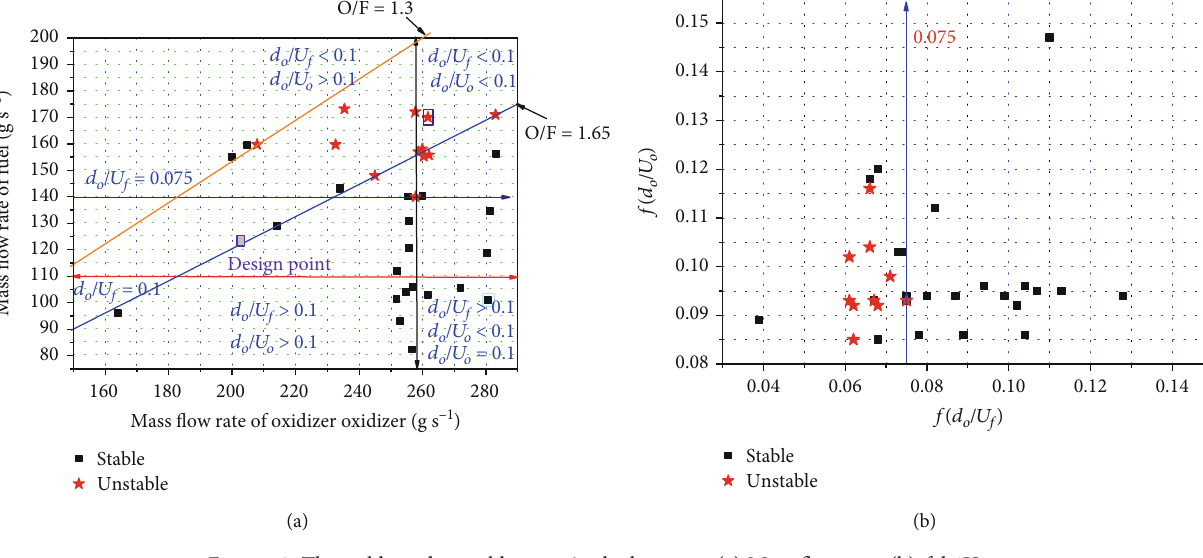
Figure 3: The stable and unstable cases in the hot tests. (a) Mass fl ow rate. (b) f d Table 2: The simulated